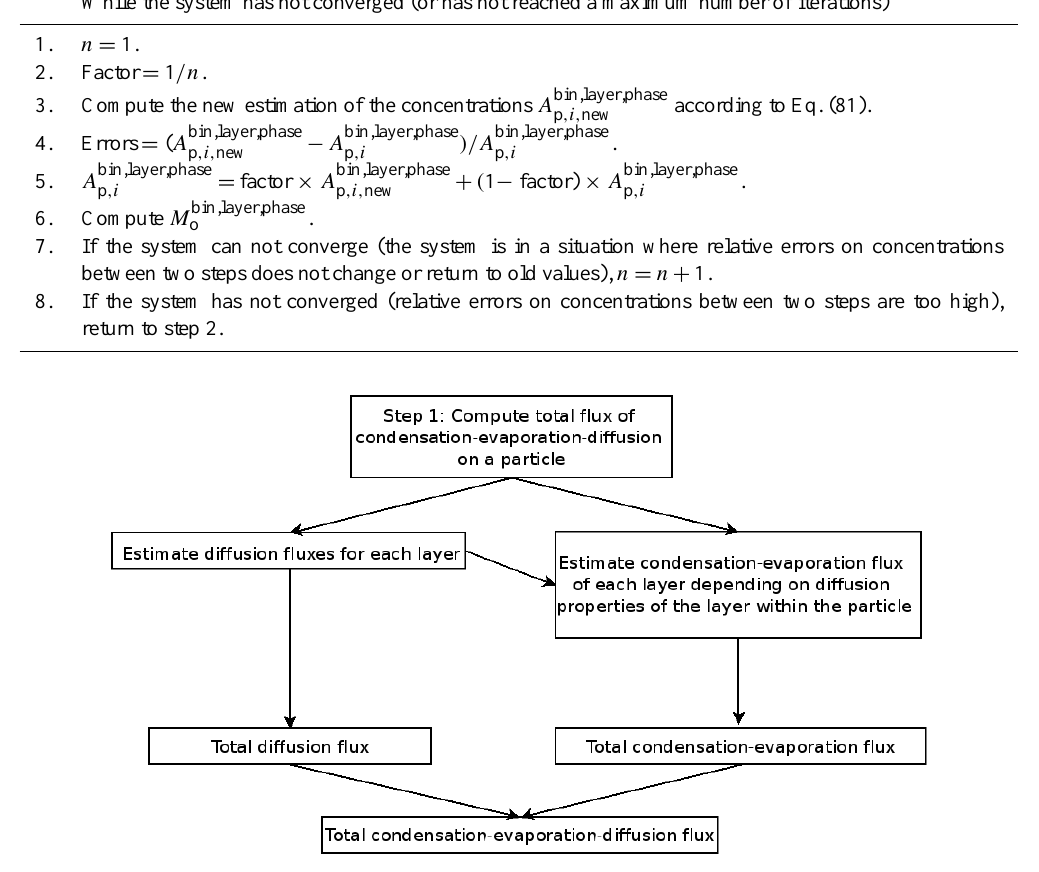
of absorption, which is (Seinfeld and Pandis, 1998) k absorption = 2 πD p D air N bin f